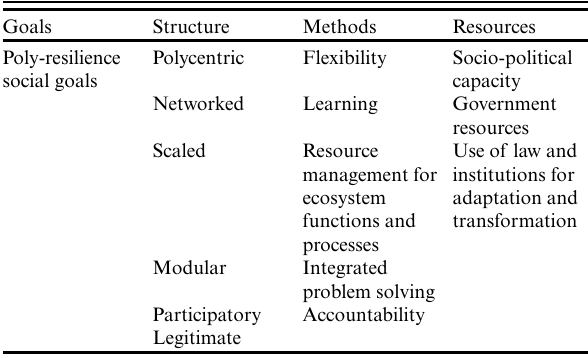
Table 3 . Framework of features of adaptive